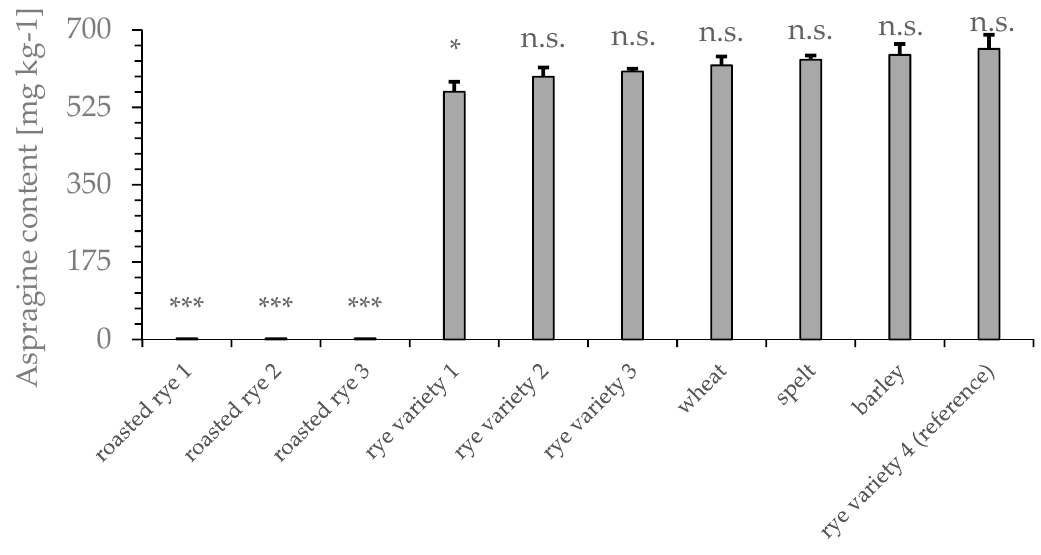
Figure 2. Free asparagine content of four rye varieties, wheat, spelt, and barley, analyzed by GC-MS after MTBSTFA derivatization. Roasted rye sample 1: 150 °C, 20 min; sample 2: 170 °C, 20 min; sample 3: 190 °C, 20 min; sample 4 (reference): 150 °C, 20 min. n = 6, *** p < 0.001 and * p < 0.05 indicate significant differences from the reference.